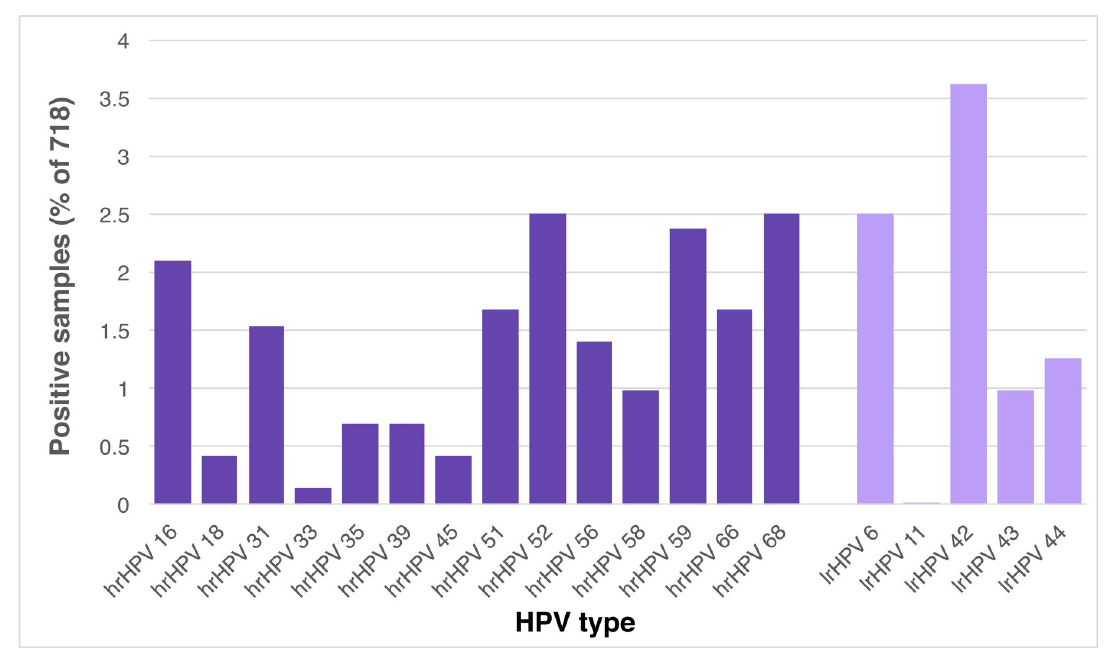
Fig 8. Distribution of the 19 HPV types in this study. A set of 718 vaginal samples was tested in the HPV genotyping assay described in this study. Of these, 142 samples were positive for at least one of the 19 HPV types validated in this study, with 100 samples positive for hrHPV, and 60 for lrHPV. In 35 of the 142 positive samples, two or more HPV types were found. Positive samples are plotted as percentage found in the total set of 718